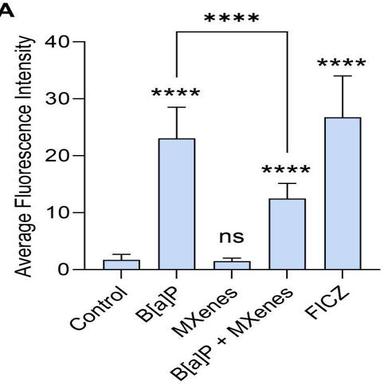
Monitoring cyp1a induction using transgenic zebrafish. (A) The average fluorescence intensity in eGFP:cyp1a transgenic zebrafish embryos after exposure for 24 h to MXenes (80 mg/L), BP (1 mg/L), and FICZ (1 μM) (25 individuals per sample). Data are presented as mean values ± S.D. of three independent experiments. One-way ANOVA with Tukey's multiple comparison test was used to analyze statistical differences between the exposures (p < 0.05, p < 0.01, p < 0.001, p < 0.0001). (B) Representative fluorescence im